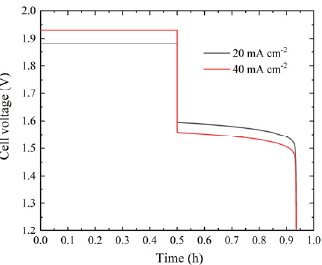
Figure 4. Ba tt ery voltages with di ff erent positive electrolyte fl ow rates at current densities of Figure 4. Battery voltages with different positive electrolyte flow rates at current densities of ( a ) 20 mA cm (cid:2879)(cid:2870) and ( b ) 40 mA cm (cid:2879)(cid:2870) . ( a ) 20 mA cm − 2 and ( b ) 40 mA cm − 2 .